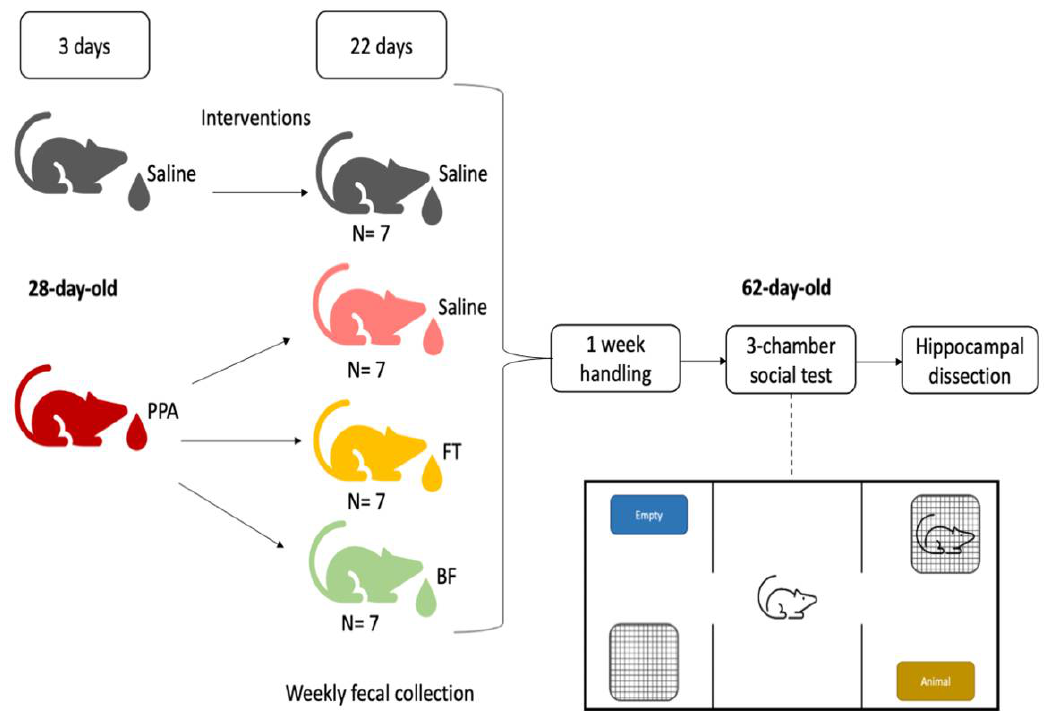
Figure 1. Study experimental design. Animals either received propionic acid (PPA) or saline for three days, after which PPA animals were treated with either saline, fecal transplant (FT), or Bifidobacterium (BF) for 22 days. Later, animals were evaluated for sociability using the 3-chamber social test and sacrificed a day later, their brains collected, and the hippocampi dissected out.